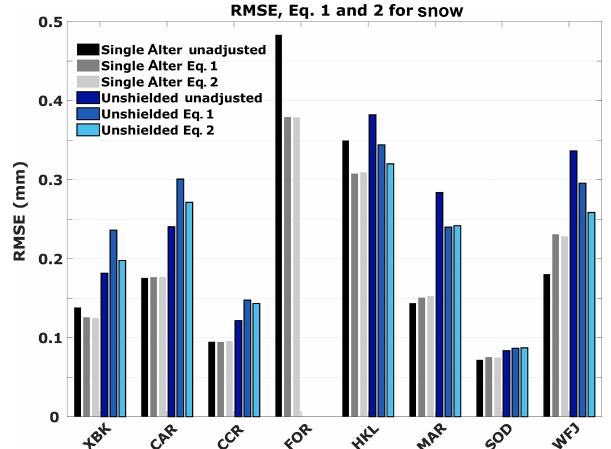
Figure 6. Root mean square error (RMSE) for snow for single Al- ter and unshielded gauges for unadjusted measurements and for ad- justments using Eqs. (1) and (2) at each of the eight SPICE sites, combining 2015/2016 and 2016/2017 winter seasons.